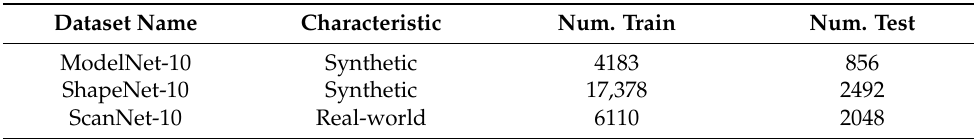
Table 1. Characteristics and compositions of the